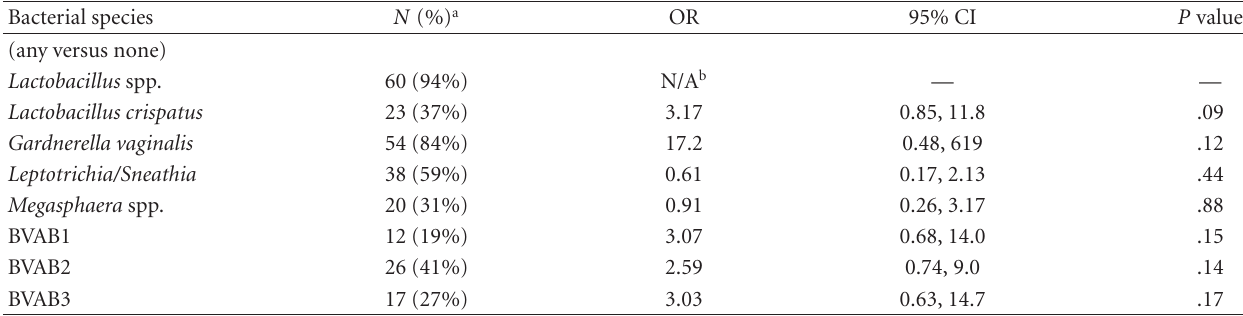
Table 2: Odds ratio for having detectable HIV-1 in cervicovaginal lavage when individual bacteria are detected by PCR. Bacterial species